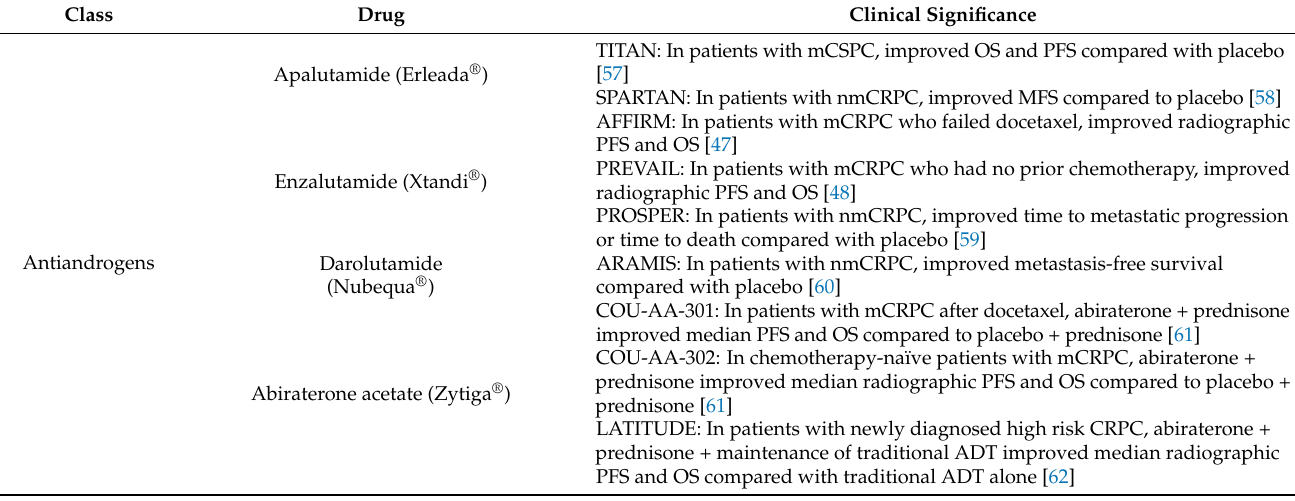
Table 1. Clinical Significance of Current Treatment Modalities for Advanced Prostate Cancer: Results from Clinical Trials. Clinical efficacy of current treatment modalities for advanced prostate cancer based on results from clinical trials.